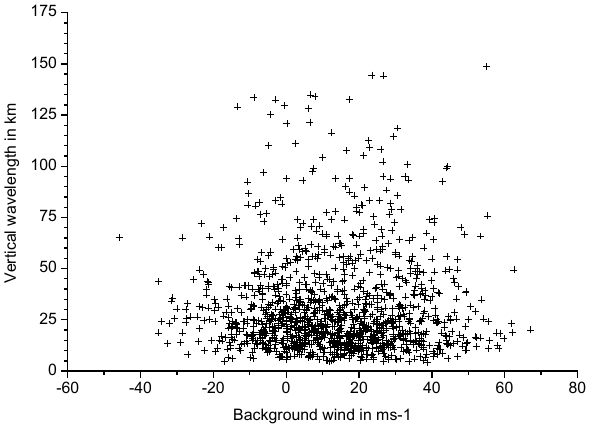
Figure 10: Vertical wavelength vs. background wind. Fig. 10. Vertical wavelength vs. background